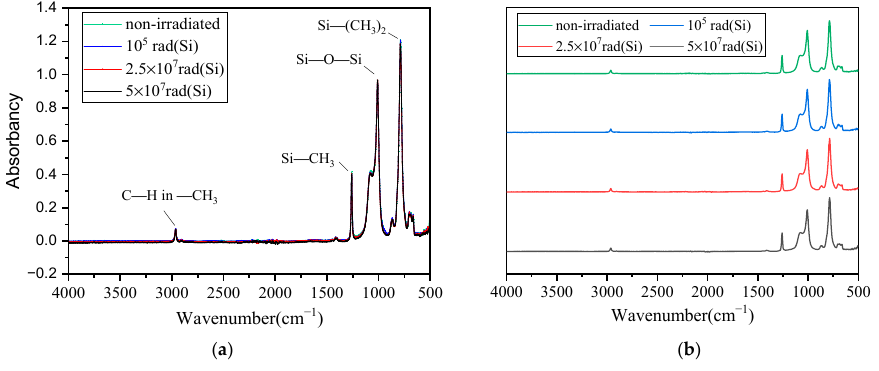
Figure 5. The spectra of the samples under different irradiation conditions. ( a ) Characteristic groups of silicone. ( b ) Comparison of infrared spectra of samples under different irradiation con- ditions. Table 3. Characteristic groups of silicone.